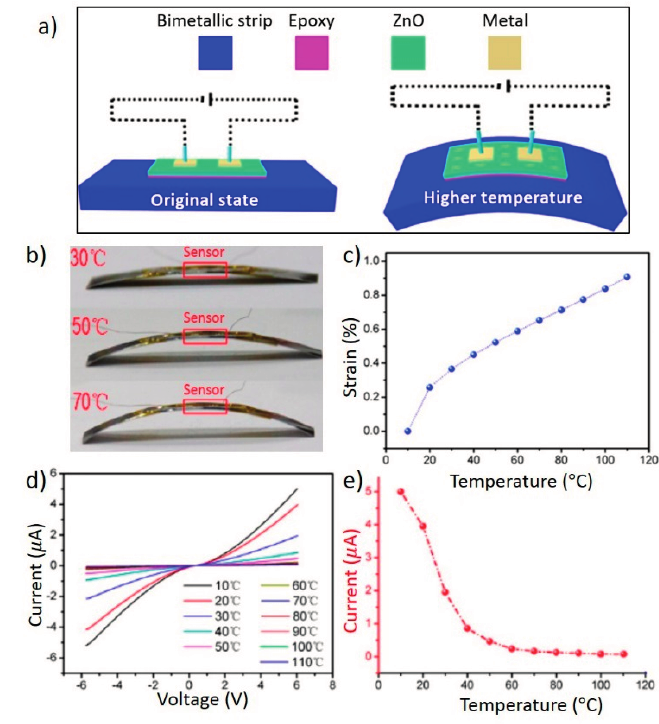
Figure 11. Piezotronic temperature sensor. ( a ) Structure of the temperature sensor and its working principle; ( b ) Photographs showing bending of the temperature sensor at different temperatures. The bimetallic strip was 5.5 cm in length and 2 cm in width; ( c ) Relationship between ambient temperature and strain on the surface of the bimetallic strip; ( d ) Current-voltage curves of the temperature sensor at different temperatures. The current amplitude decreased as the temperature increased; ( e ) Current of the sensor at different temperatures, with the bias fixed at 6 V. Reprinted with permission from [90] (Copyright 2014, American Chemical